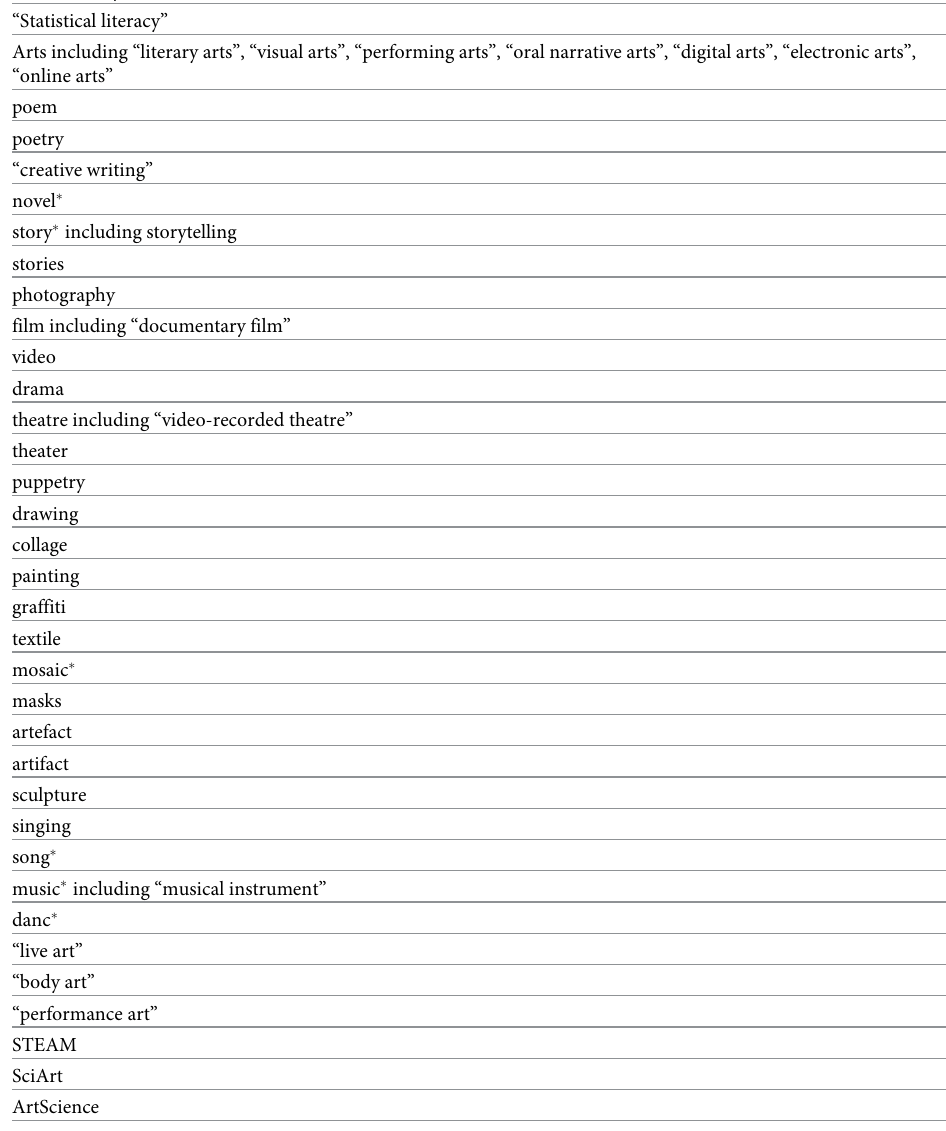
Table 3. Terms related to data literacy and the arts. “Data